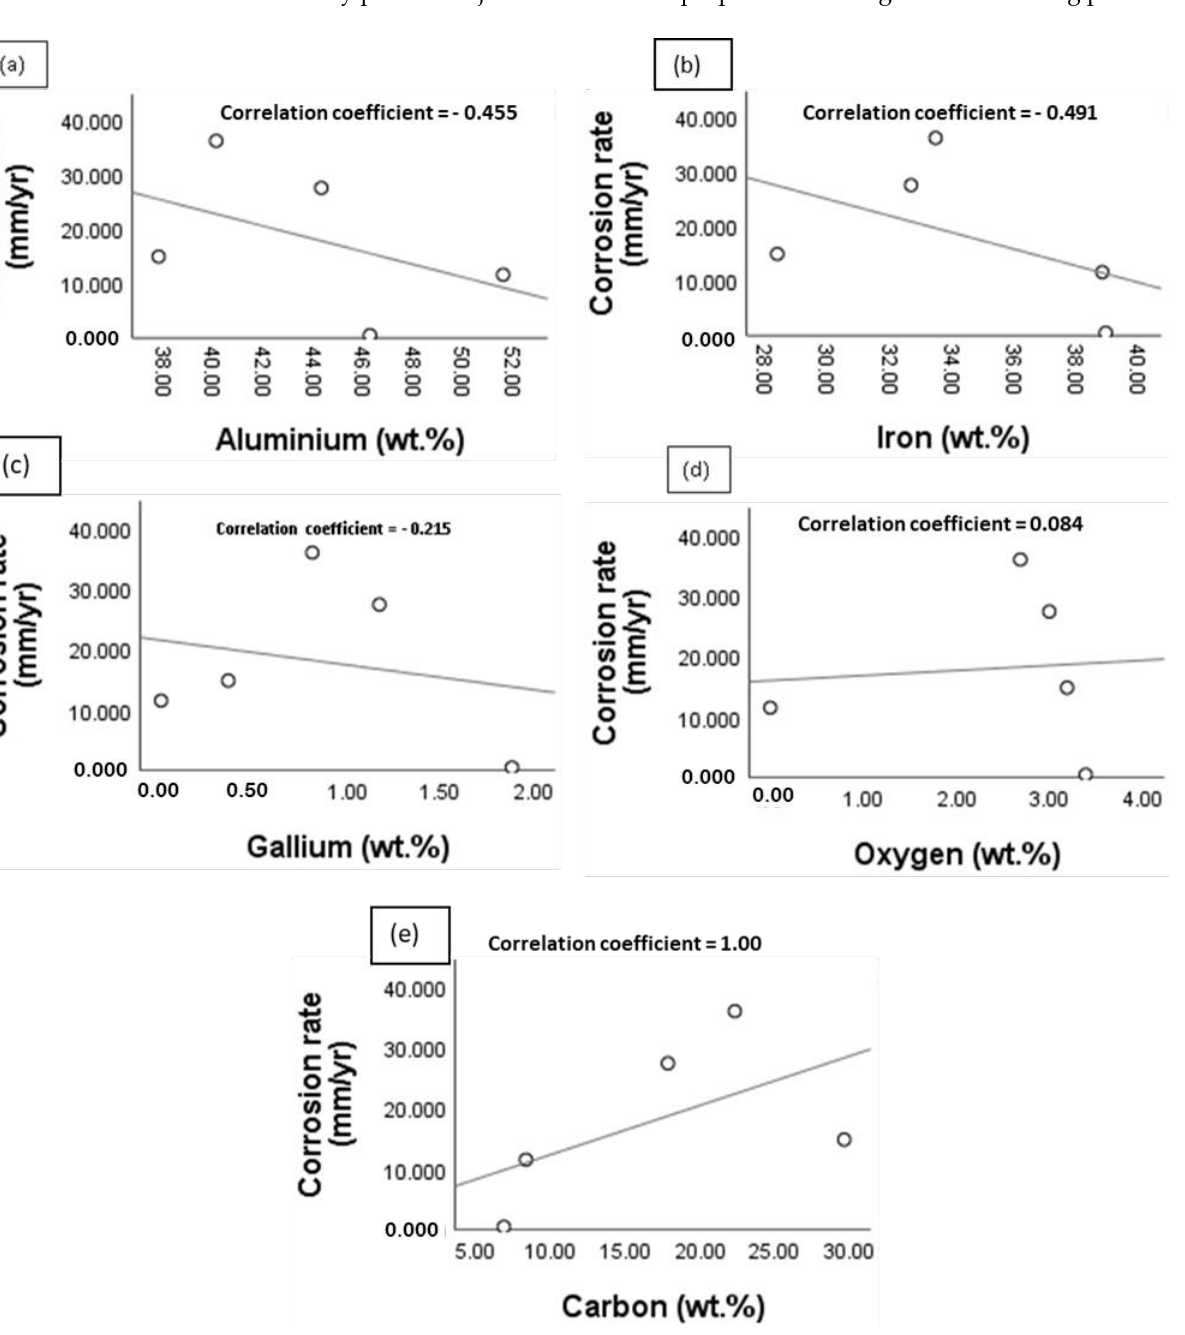
Figure 16. Scatter plot of the corrosion rate (mm/yr) against the elemental composition (wt.%) of the reaction layer: ( a ) corrosion rate against Al; ( b ) corrosion rate against Fe; ( c ) corrosion rate against Ga; ( d ) corrosion rate against O; ( e ) corrosion rate against C.